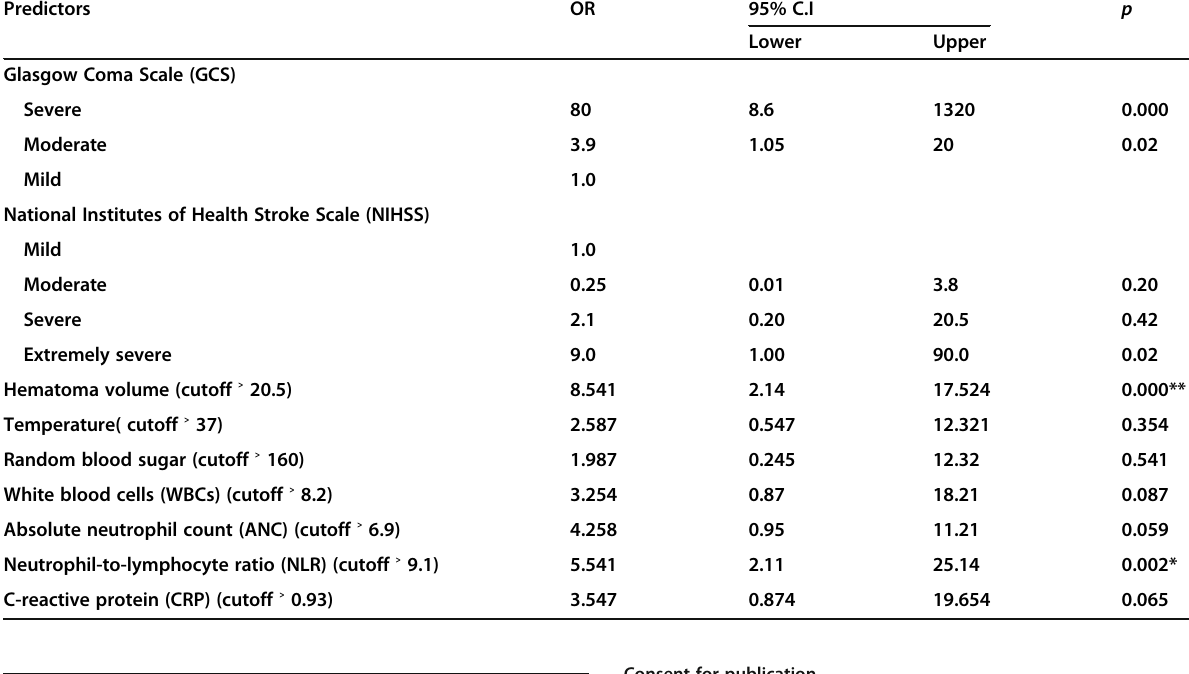
Table 4 Multivariate logistic regression for independent predictors of early neurological deterioration (END)